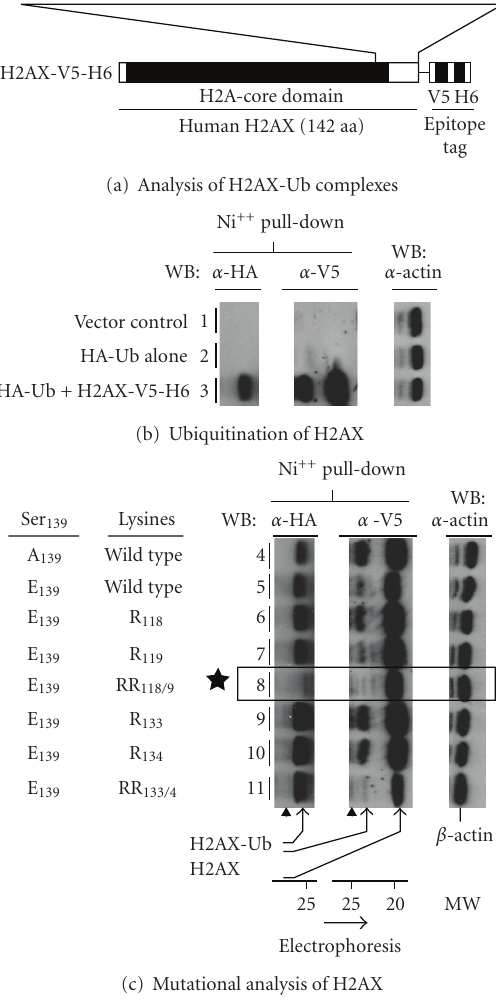
Figure 3: H2AX-E 139 is ubiquitinated at K 118 or K 119 . (a) Critical amino acids within the C-terminus are shown. (b) HA-tagged ubiquitin (HA-Ub) was transfected into cells with or without H2AX-V5-H6. His-tagged (H6) proteins were purified from chro- matin fractions then probed sequentially for the presence of HA- ubiquitin and V5 epitopes (WB). 10% of the unfractionated extract was blotted directly and probed for β -actin. (c) H2AX variants containing E 139 (to mimic S 139 phosphorylation) and various lysine (K) to arginine (R) Substitutions were transfected with HA-tagged ubiquitin. Histidine-tagged proteins were purified from chromatin fractions then probed sequentially for the presence of HA-ubiquitin and V5 epitopes. 10% of the unfractionated extract was blotted directly and probed for β -actin. The star (lane 8) indicates the absence of HA-tagged ubiquitin. Arrows indicate unmodified and ubiquitinated